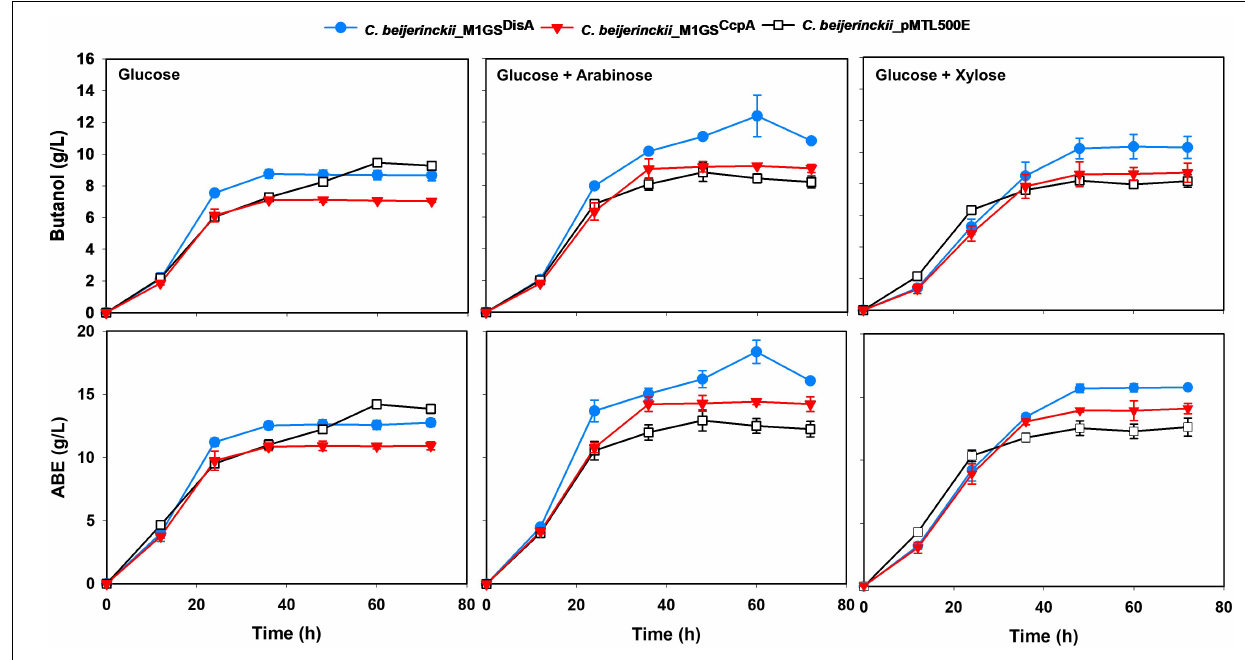
FIGURE 2 | Butanol and ABE titers during a 72-h fermentation in cultures of C. beijerinckii _pMTL500E, _M1GS CcpA , and _M1GS DisA on glucose, glucose + arabinose, and glucose + xylose. Error bars represent standard deviation of the mean ( n =